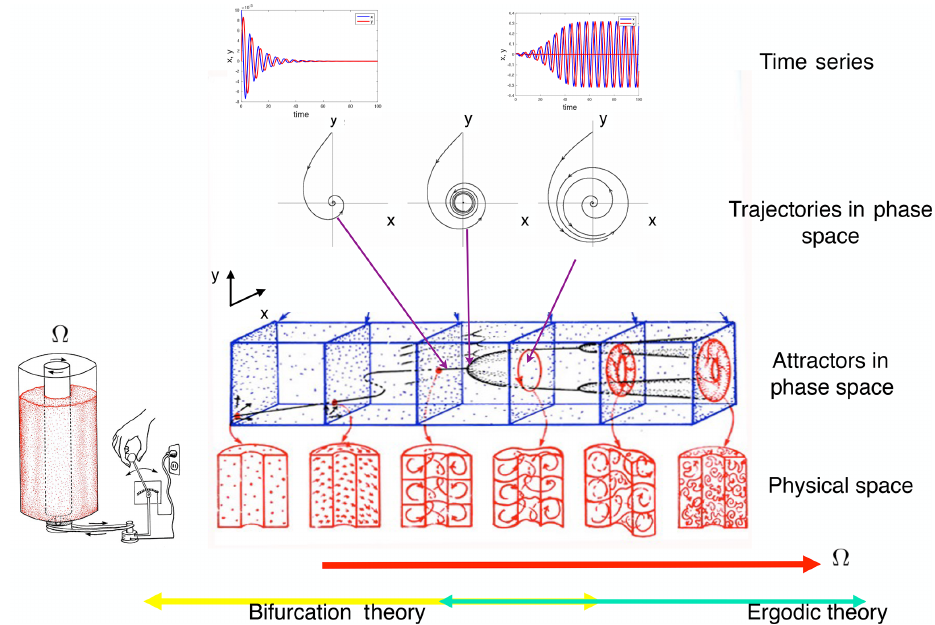
Figure 2. Sketch of dynamical systems concepts and approaches for the Taylor–Couette flow (as modified from Abraham and Shaw, 1992). Time series, trajectories and the geometrical view of attractors are sketched. Transition behavior at small values of (cid:127) can be addressed by bifurcation theory; for large values of (cid:127) it can be tackled using ergodic